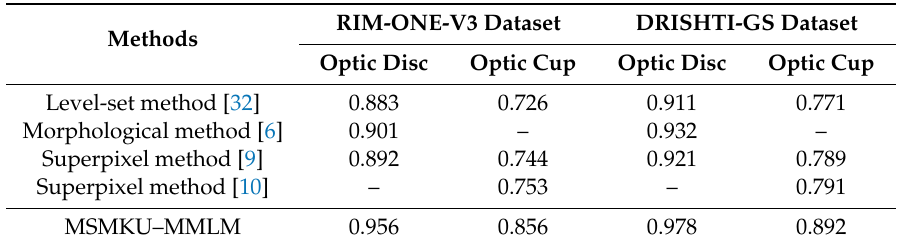
Table 1. F -score comparisons with classical methods for the segmentation of optic disc (OD) and optic cup